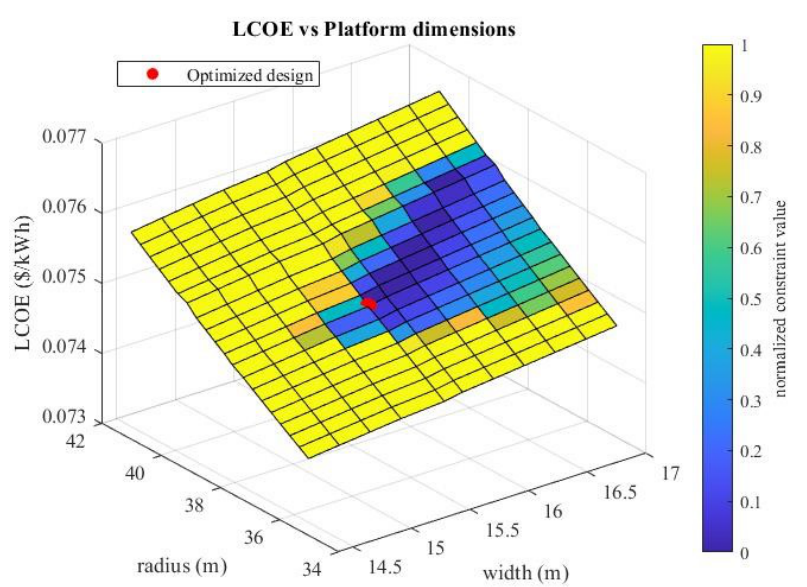
Figure 18. Surface plot of LCOE vs. radius and width with constraint values overlayed on the surface.